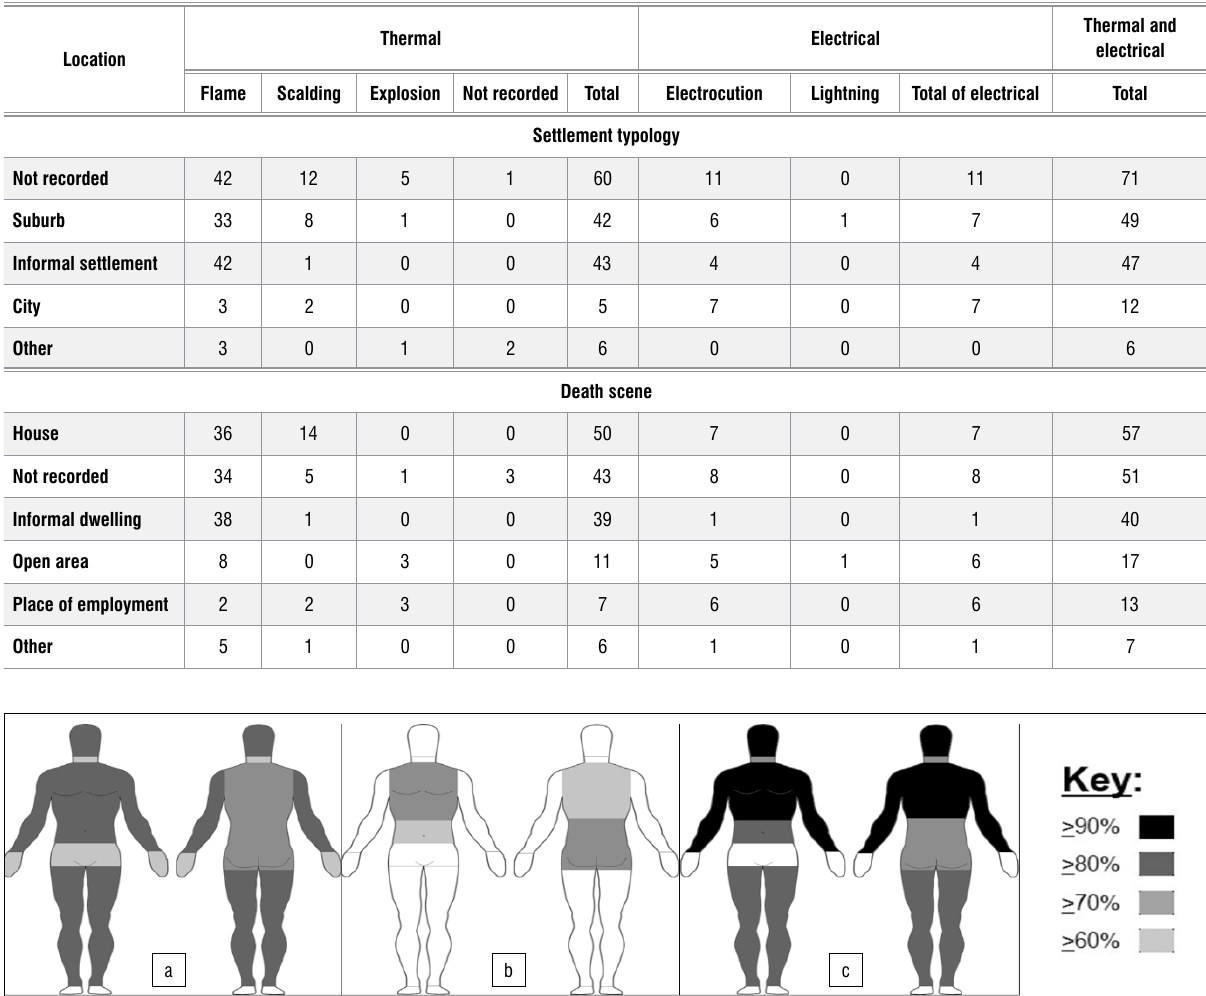
Burn mortality death scenes in Johannesburg described by location and site